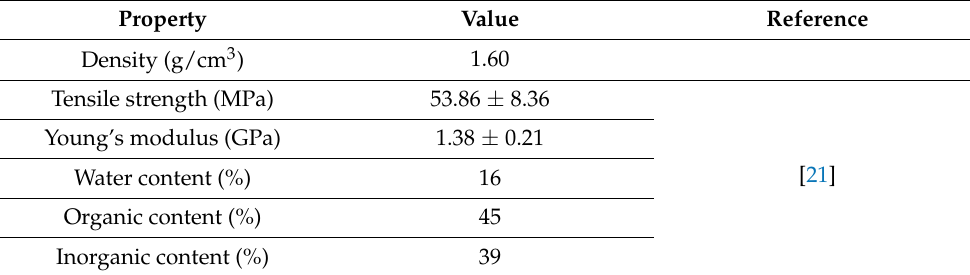
Table 1. The mechanical and physical characteristics of arapaima scales.